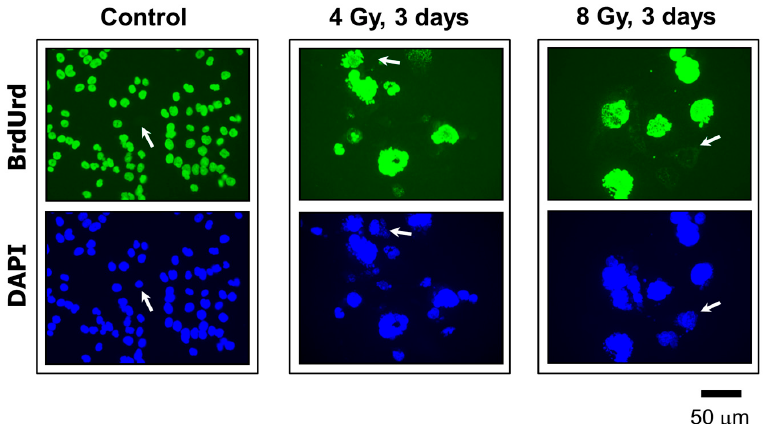
Figure 8. Representative images showing proliferating cells (BrdUrd-positive; green) and total cells (DAPI; blue) in HCT116p53 − / − cultures acquired before and three days after irradiation. In all experiments, BrdUrd was added to the culture medium for the final 24 h of the incubation period to allow its incorporation into genomic DNA. Arrows show some cells that did not incorporate BrdUrd under these conditions. All images were acquired at the same magnification. under these conditions. All images were acquired at the same magnification.